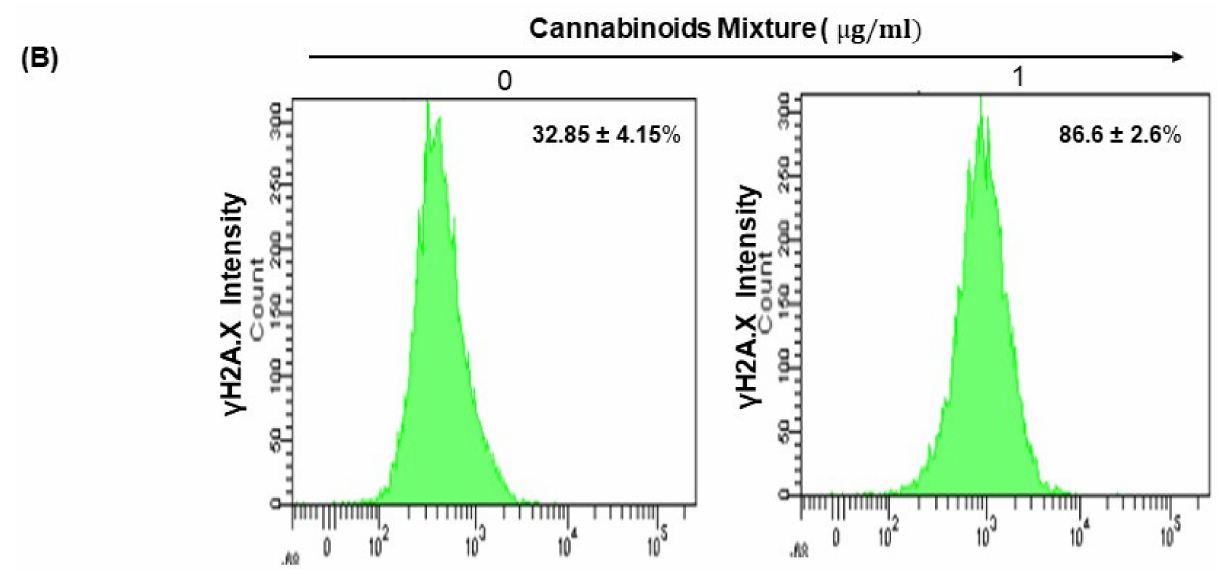
Figure 6. Cannabinoid mixture affects Ca9-22 cell morphology and induces DNA damage. ( A ) Mor- phology of Ca9-22 cells that were seeded at low density in the presence of CM for 24 h as described in Materials and Methods. ( B ) Flow cytometry expression profiling of γ H2A.X after CM treatment. Cells were grown on Petri dishes and stimulated by CM at 1 µ g/mL (IC50 concentration) ( n = 3). The white arrow represents the nucleus damage caused by CM.